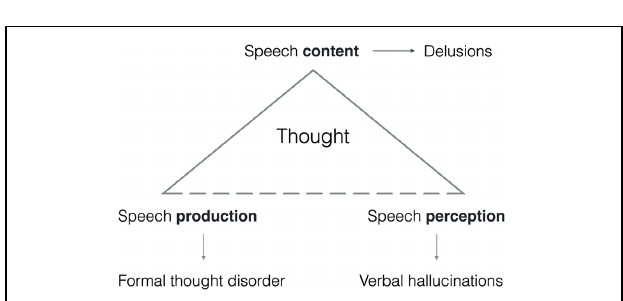
FIGURE 2 | The three positive symptoms derived as a breakdown of the linguistic frame of thought. Human language organizes speech perception, production, and content as the co-dependent angles of a triangle. Depending on which corner is affected most, symptoms result.